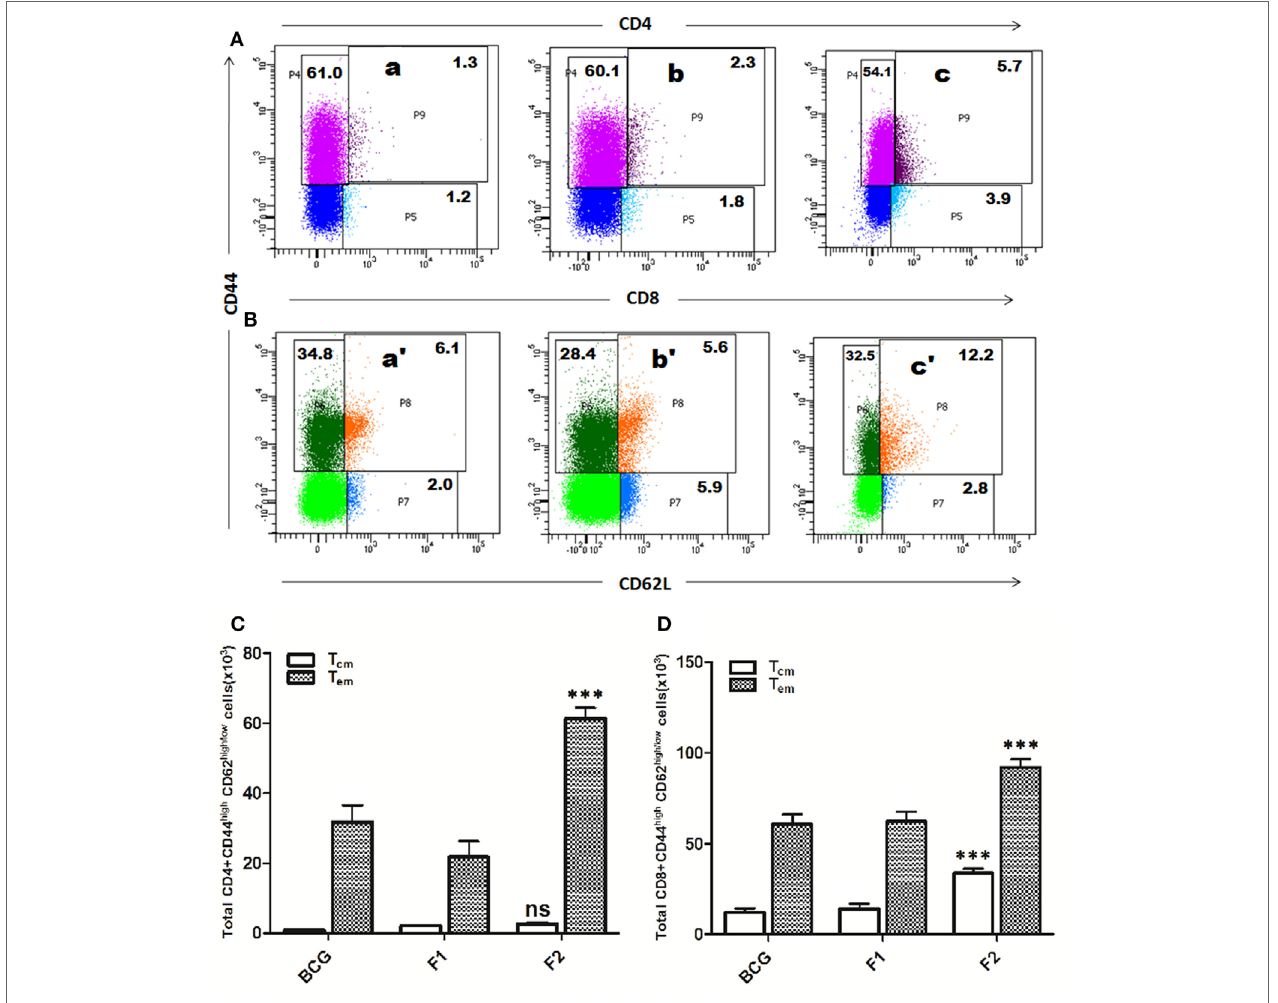
FigUre 8 | Immunization schedule involving Ag85B aggregates evokes antigen-specific T cell memory (effector/central) response in the host. The splenocytes were isolated from various immunized groups at 1 week post booster and analyzed for the presence of CD44 high , CD62L low/high CD4 + , and CD8 + T cells. The representative FACS dot plots of gated (a) CD4 + T cells, and (B) CD8 + T cells belonging to various immunized groups are denoted in the upper panel. Various experimental groups included in the study were: Bacillus Calmette–Guerin (BCG) (a and a ′ ), Ag85B-IFA or F1 (b and b ′ ), and amyloidal aggregate form of Ag85B or F2 (c and c ′ ). Graphs in the lower panel (c,D) depict quantitave data of analyzed memory markers belonging to corresponding CD4 + and CD8 + T cells. Bar graphs indicate total number of CD4 + CD44 high , CD62L low/high (c) , and CD8 + CD44 high , CD62L low/high (D) cells, respectively, in various groups. The data were analyzed by employing two-way ANOVA followed by Bonferroni’s multiple comparison test and are shown as means ( ± SD) of three independent experiments. (c) Aggregated Ag85B (F2) Vs BCG: p < 0.001 CD4 + T effector memory ; p = ns CD4 + T central memory ; Ag85B-IFA (F1) Vs BCG: p < 0.01 CD4 + T effector memory ; p = ns CD4 + T central memory , aggregated Ag85B (F2) Vs Ag85B-IFA (F1): p < 0.001 CD4 + T effector memory ; p = ns CD4 + T central memory . (D) Aggregated Ag85B (F2) Vs BCG: p < 0.001 CD8 + T effector memory , CD8 + T central memory